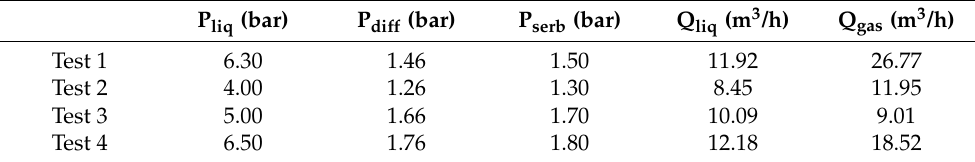
Table 7. Excerpt of tests performed for performance evaluation.